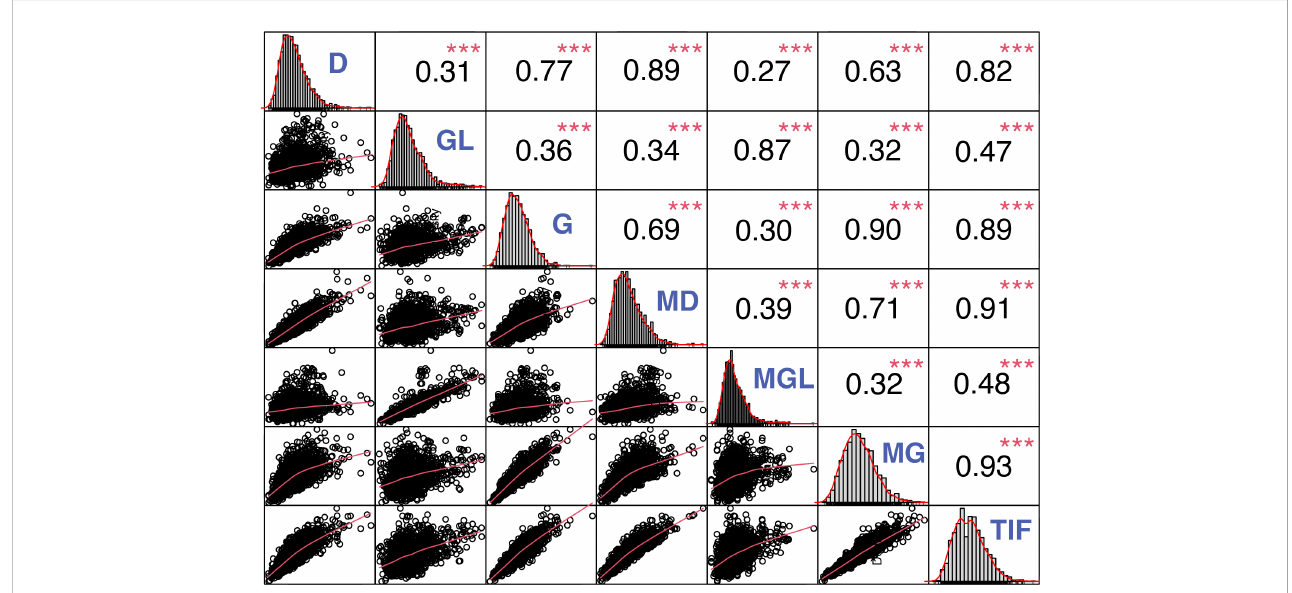
FIGURE 2 Correlation analysis among the individual and TIF content in soybean seeds. *, **, and *** represent signi fi cance at p < 0.05, 0.01, and 0.001, respectively. D, Daidzin; GL, Glycitin; G, Genistin; MD, Malonyldaidzin; MGL, Malonylglycitin; MG, Malonylgenistin; TIF, Total iso fl